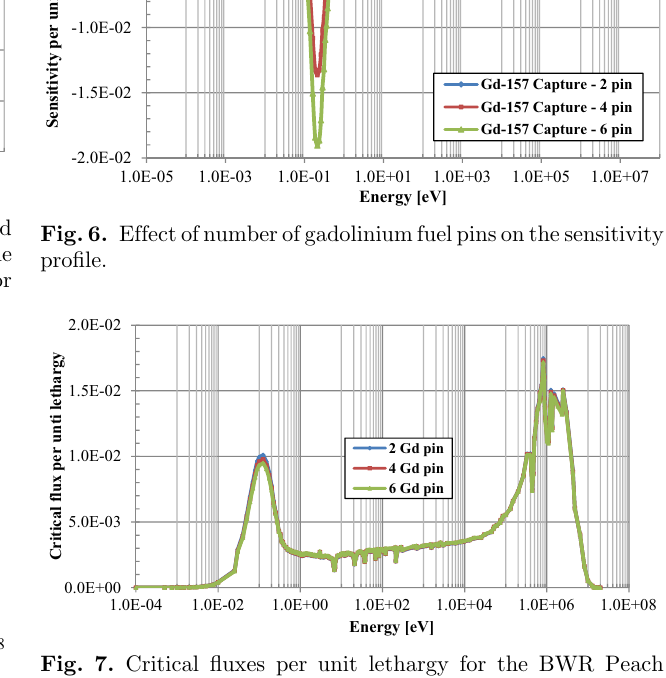
Fig. 5. Critical fl uxes per unit lethargy for the BWR GE10 (cid:3) 10-8 FA for three different moderator densities.